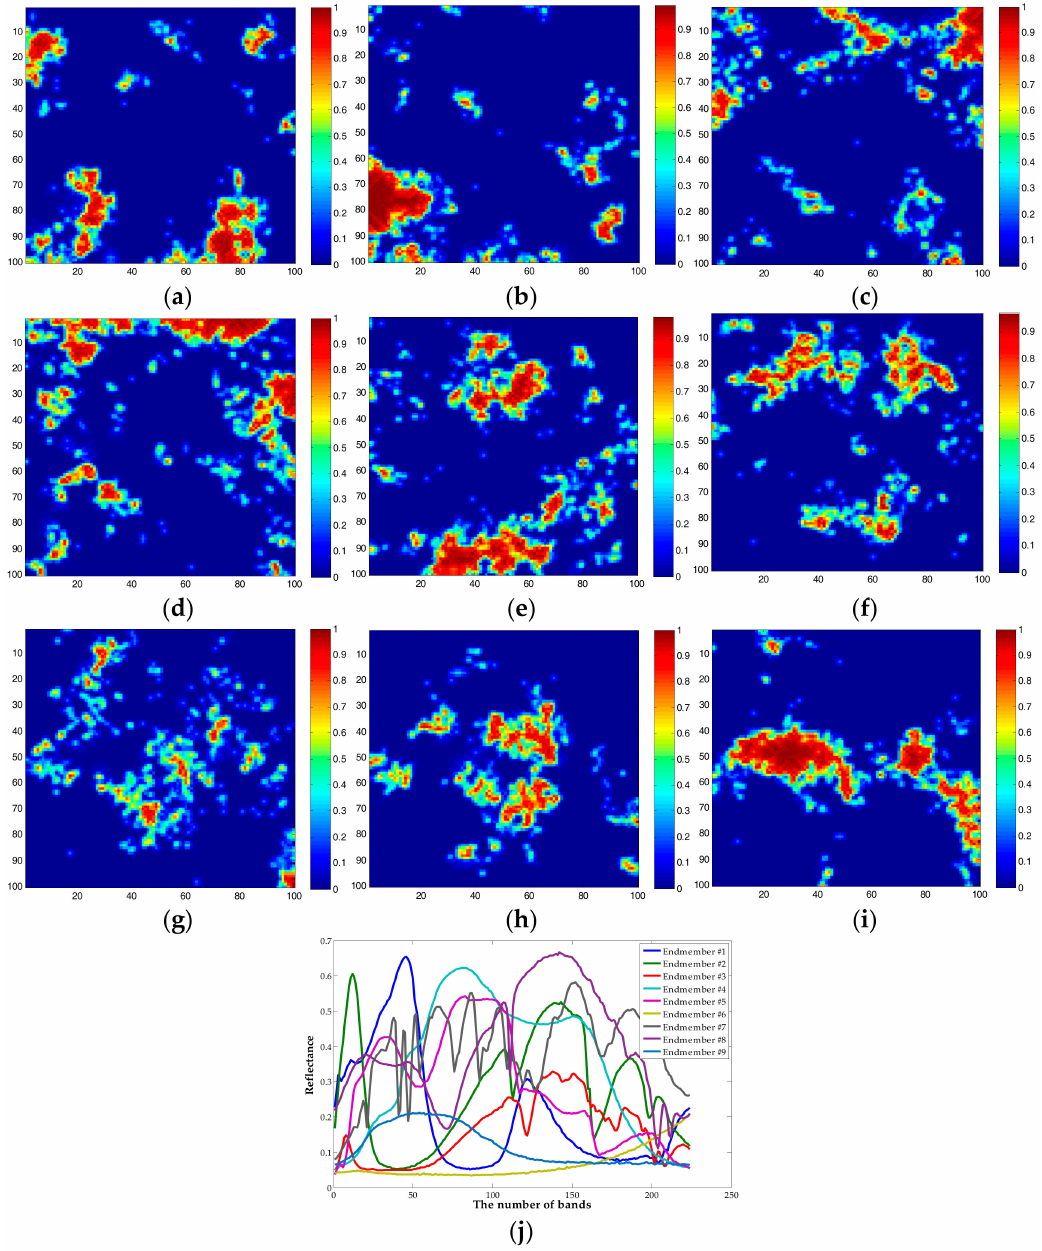
Figure 3. Simulated dataset S-2. ( a ) Abundance map of #1. ( b ) Abundance map of #2. ( c ) Abundance map of #3. ( d ) Abundance map of #4. ( e ) Abundance map of #5. ( f ) Abundance map of #6. ( g ) Abundance map of #7. ( h ) Abundance map of #8. ( i ) Abundance map of #9. ( j ) The nine spectral